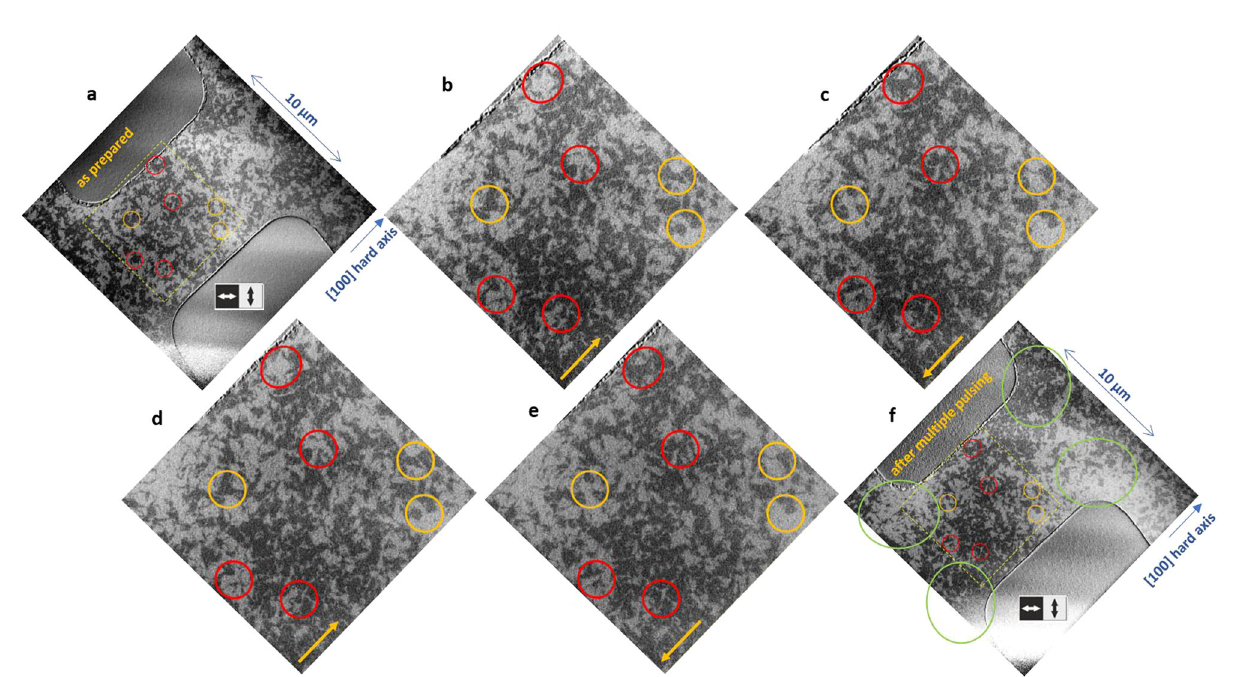
Fig. 3 | XMLD-PEEM images of Néel vector reorientation, with current parallel hard axis. The images show the orientation of the Néel vector of Mn 2 Au(001) thin fi lms as grown a and after sending current pulses (length 1 ms, amplitude J =3.6×10 11 A/m 2 ) with alternating polarity indicated by yellow arrowsalong the